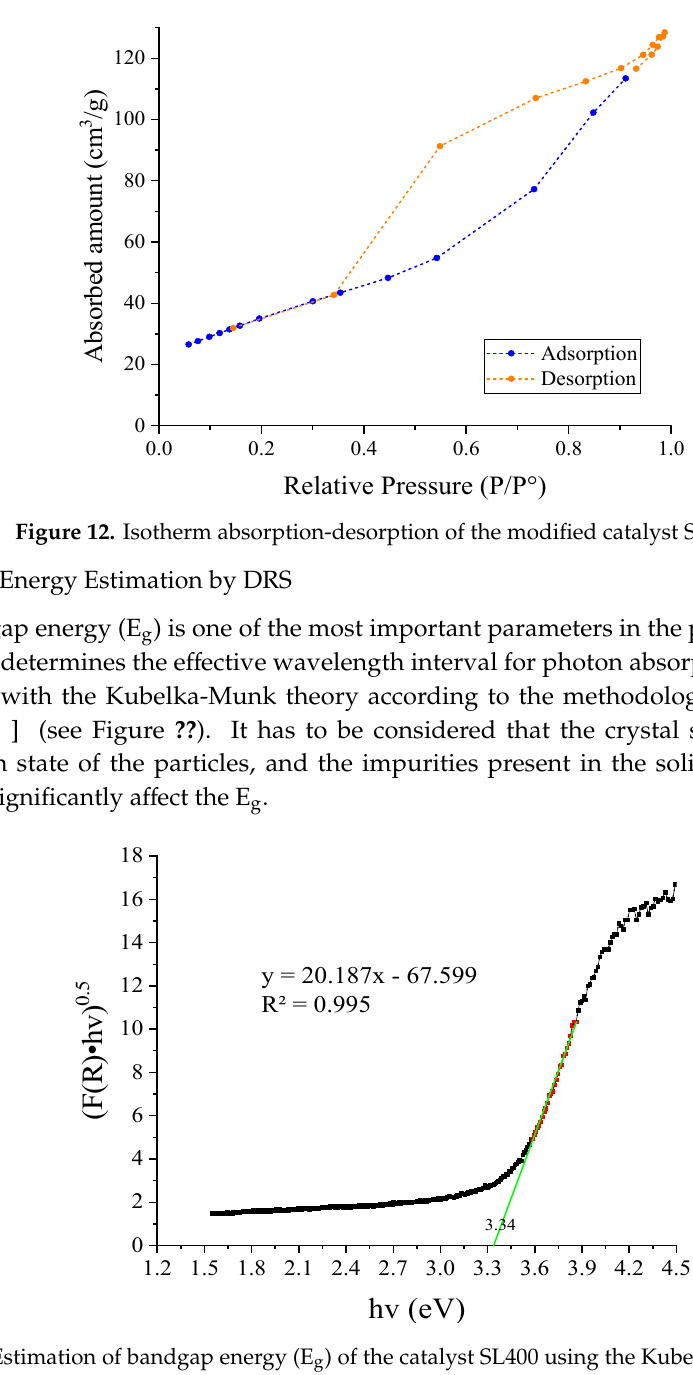
Figure 12. Isotherm absorption-desorption of the modified catalyst SL400.